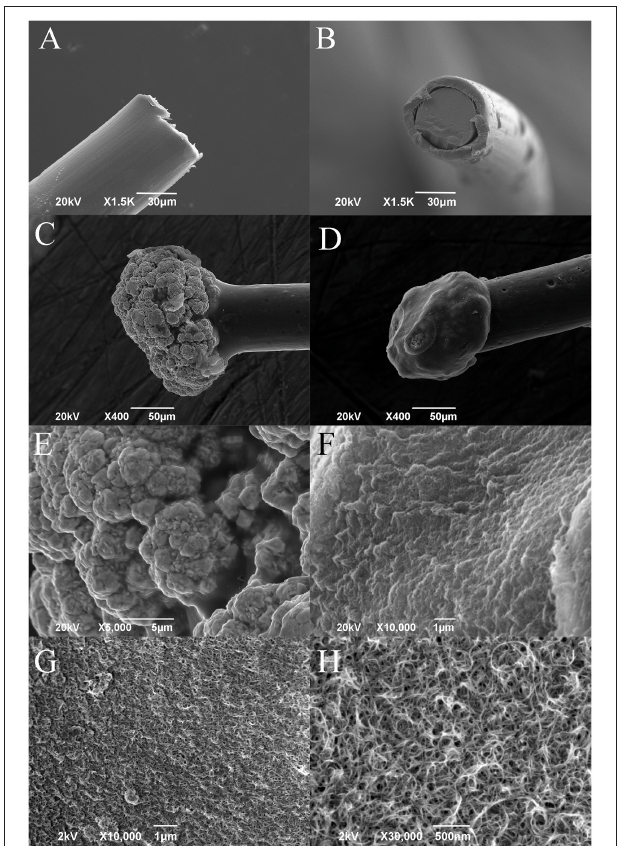
FIGURE 2 | Representative SEM images of (A,B) platinum wire before deposition (lateral and frontal view), (C) gold microsphere, and (D) PEDOT-PSS-CNT coated microsphere. Higher magnification images of the surface morphology of (E) nanostructured gold and of (F) PEDOT-PSS-CNT composite obtained by Zeiss EVO 40 SEM. High resolution images of (G,H) PEDOT-PSS-CNT composite obtained by Jeol JSM-7500FA